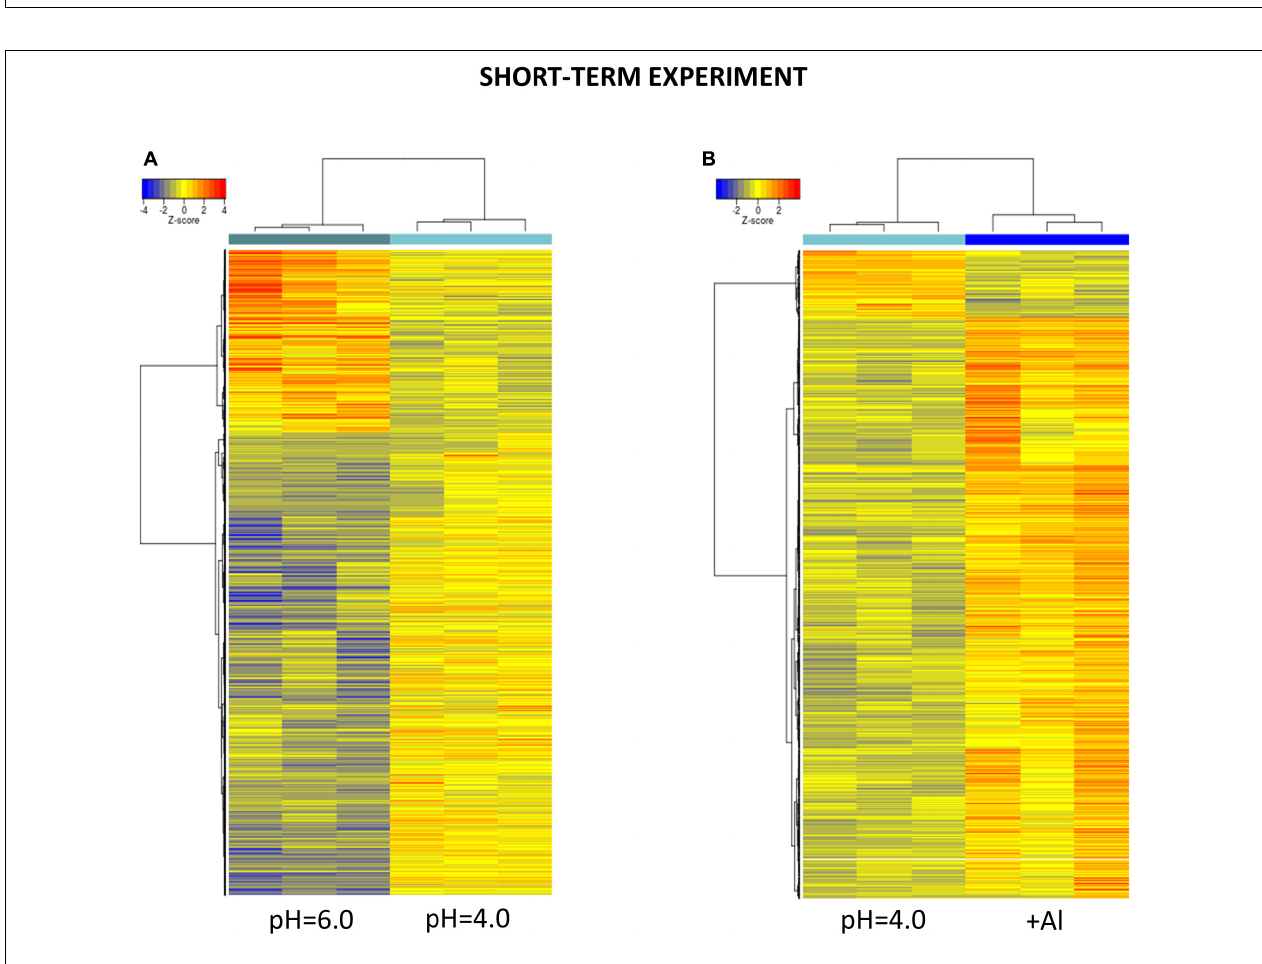
FIGURE 6 | Hierarchical clustering of samples using distance based on Pearson’s correlation coefficient with Ward D2 linkage algorithm for a set of genes differentially expressed in barley root meristems in the short-term experiment. Gene counts were regularized log (rlog) transformed with library size-wise normalization, scaled and centered to be represented as z -scores in the log2 scale. The heat map represents the relative expression levels of DEGs. (A) The comparison between pH = 4.0 and pH = 6.0. (B) The comparison between Al-treatment at pH = 4.0 and pH = 4.0 without Al.